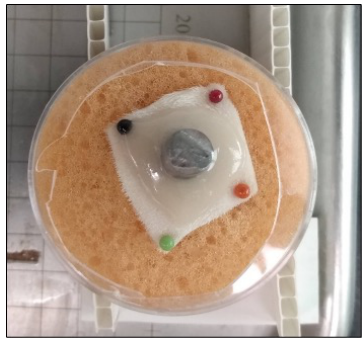
Figure 4. Ex Vivo skin sample with 1.5 mL oregano